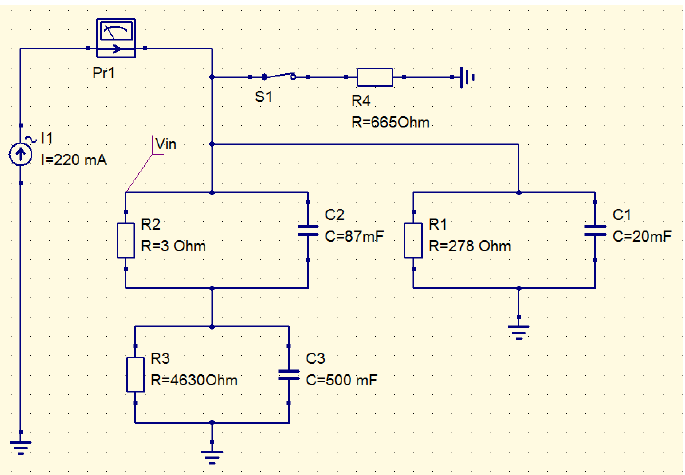
Figure 8. QUCS model of the WiPirani